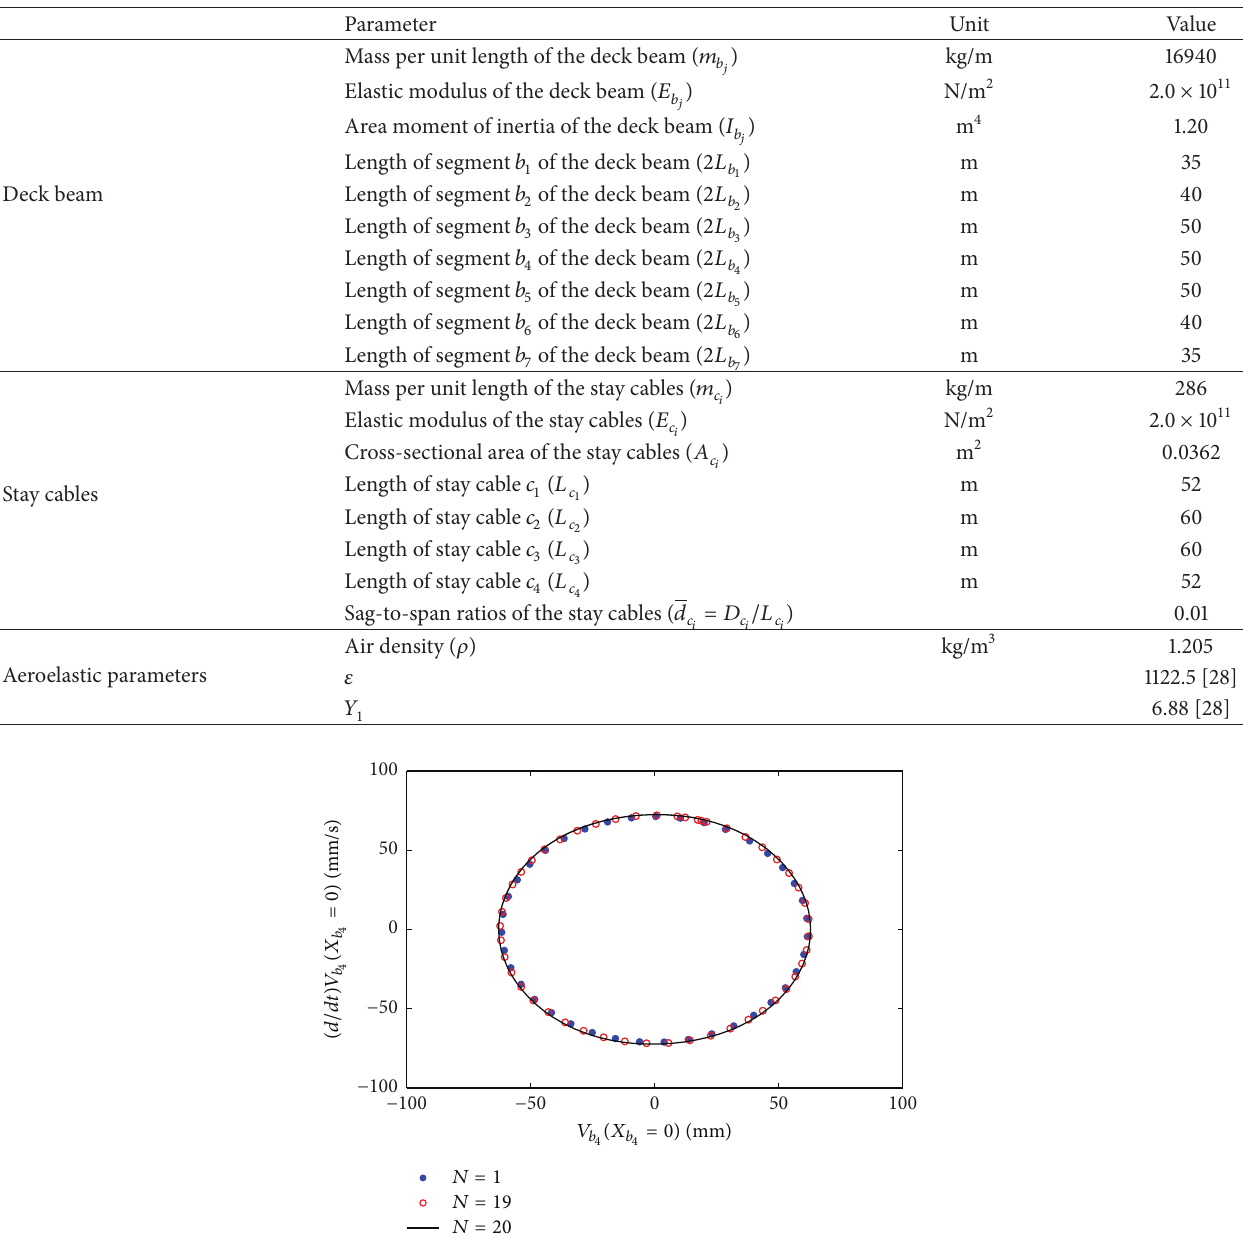
Figure 3: Phase portraits of the response of the midpoint of the deck beam for different numbers of Galerkin truncation terms, 𝑞 𝑟 (0) = 0.1𝛿 1𝑟